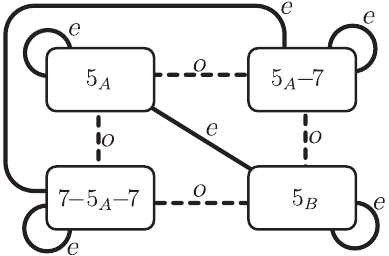
FIG. 12. The listed vertex types must be separated by paths of even ( e , solid lines) or odd ( o , dashed lines) length if the vertices are separated by an even number of monomer membranes (including zero). If the vertices are separated by an odd number of monomer membranes, e and o should be interchanged. The ” excludes the “ 5 − 7 ” and “ 7 − 5 − 7 ” box labeled “ 5 A A A − 7 excludes 7 − 5 − 7 . See Fig. 10 configurations, and 5 A A and Sec. IV